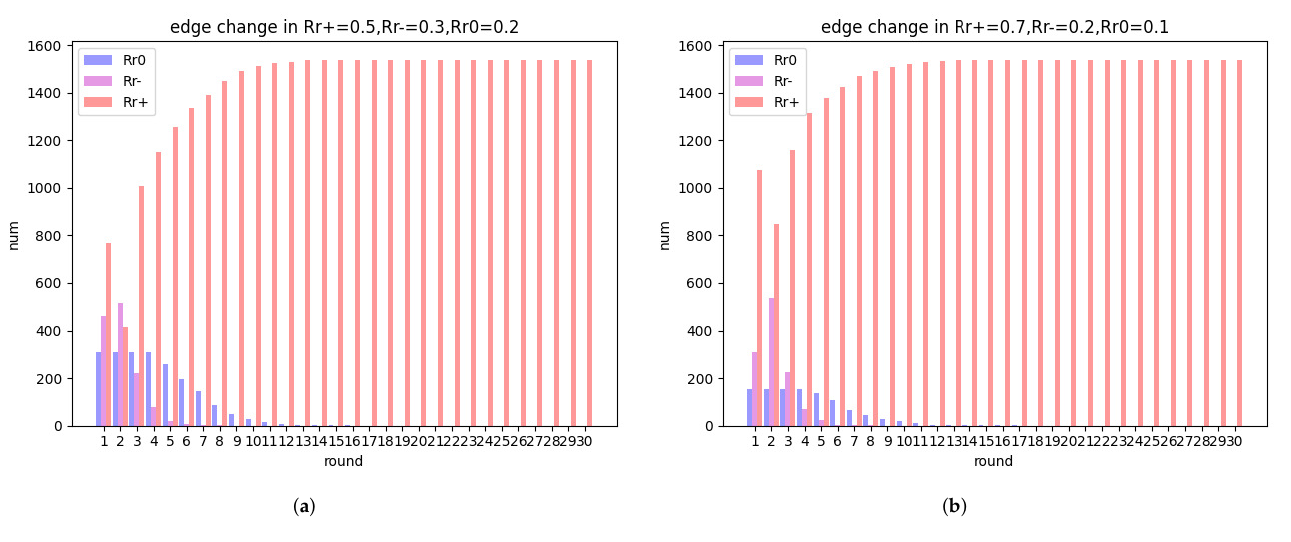
Figure 14. Changes in the number of various edges: ( a ) edges change in R r + = 0.5, R r − = 0.3,